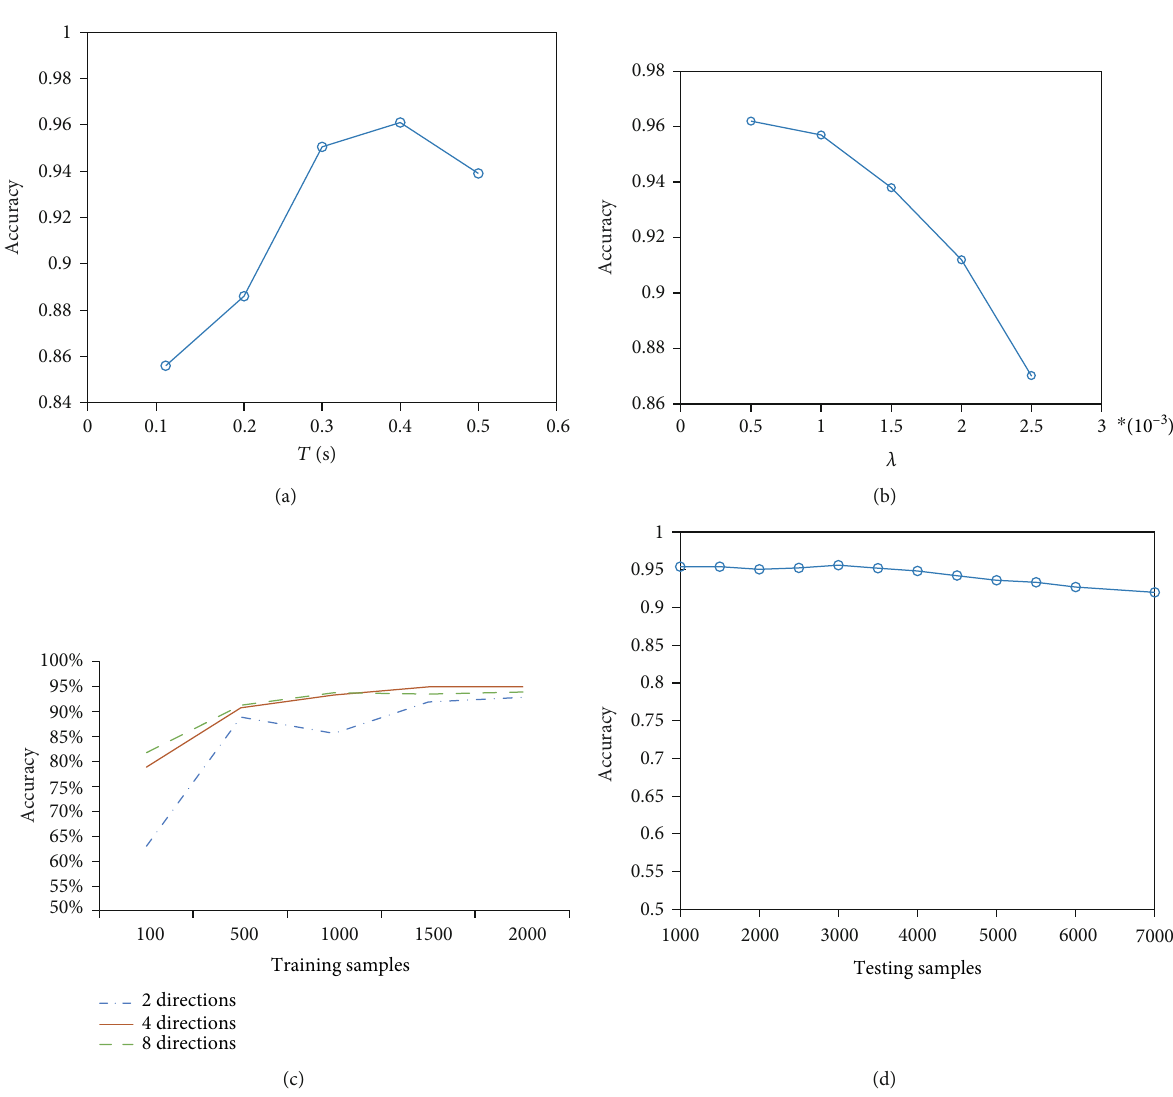
Figure 3: The in fl uence of the time window T (a) and weights updating amount λ (b) on the classi fi cation accuracy of our model. In this paper, we choose the optimal value as T = 400 ms and λ = 0 : 001 . (c) The in fl uence of training samples on the computational performance of this model with 2 , 4 , or 8 directions in the V2 layer, where testing samples are 1000 . (d) The in fl uence of testing samples on the computational performance, where training samples are 2000 . Table 1: Comparisons with other spiking-based models on the performance of MNIST